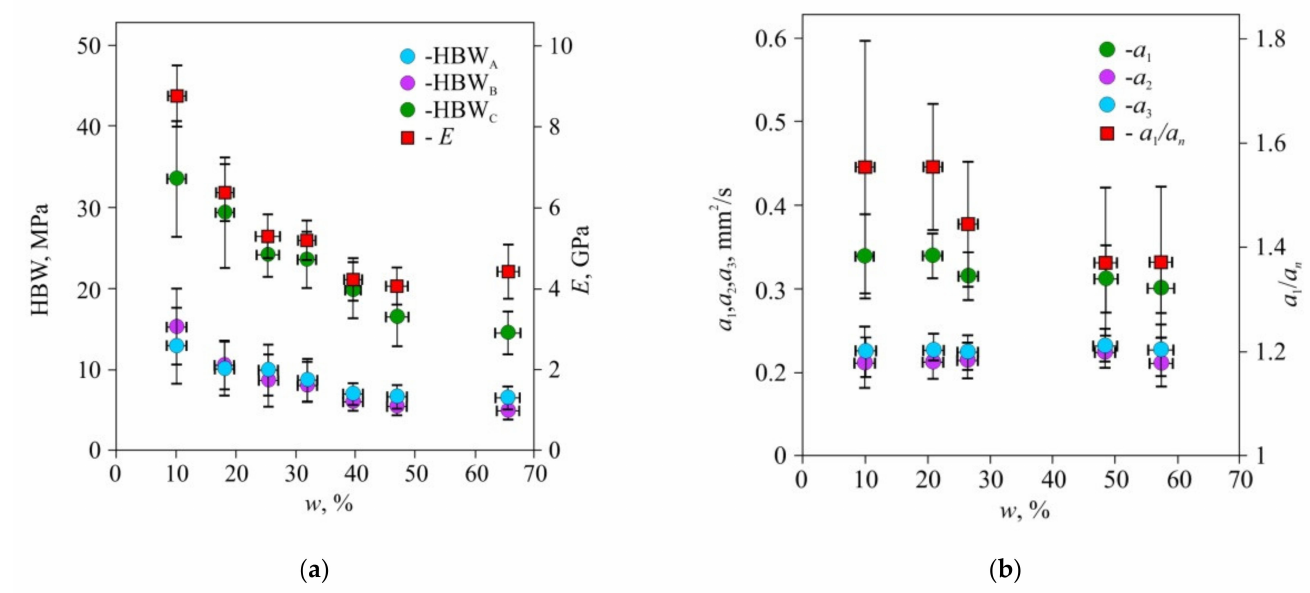
Figure 4. Dependency of Brinell hardness HBW and Young’s modulus E ( a ), thermal diffusivity coefficients a 1 , a 2 , a 3 , and a 1 /a n ratio ( b ) upon humidity w of pine wood. HBW A , HBW B , HBW C - Brinell hardness on radial, tangential, and cross-fiber cuts (A, B and C at Figure 2 accordingly). E —Young’s modulus across the fibers measured by three-point bending; a 1 , a 2 , a 3 —tangential, radial, and cross-fiber coefficients of thermal diffusivity; a n = ( a 2 + a 3